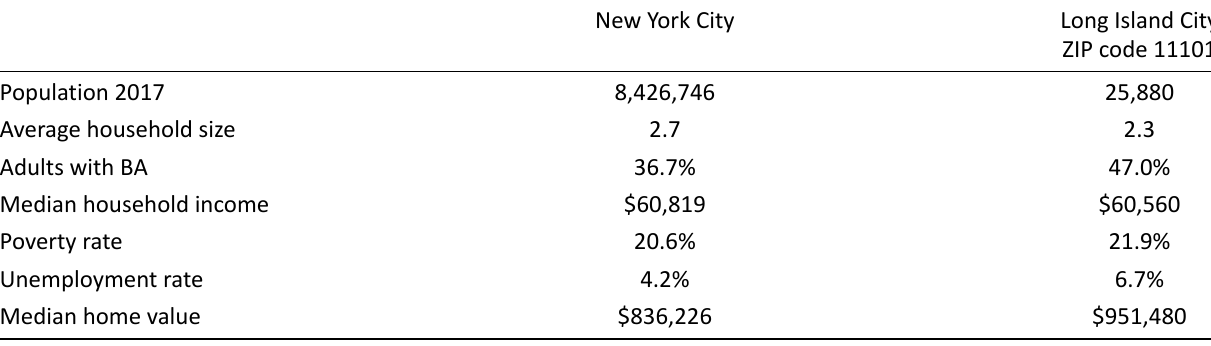
Table 1. Socio-economic characteristics of the Long Island City area 2017 according to the American Community Survey